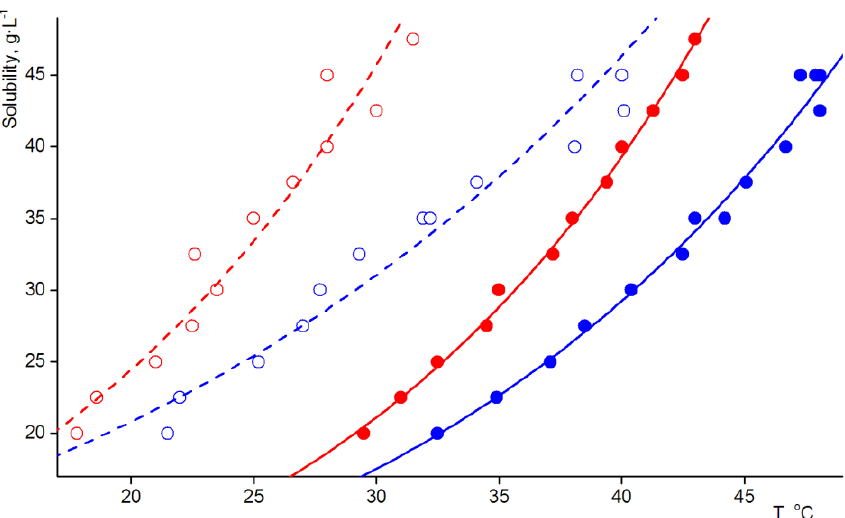
Figure 1. Temperature dependence of solubility (per single enantiomer, solid lines and circles) and for onset of crystallization (dashed lines, hollow circles) of rac - 1 (red) and ( S )- 1 (blue) in methyl tert -butyl ether.